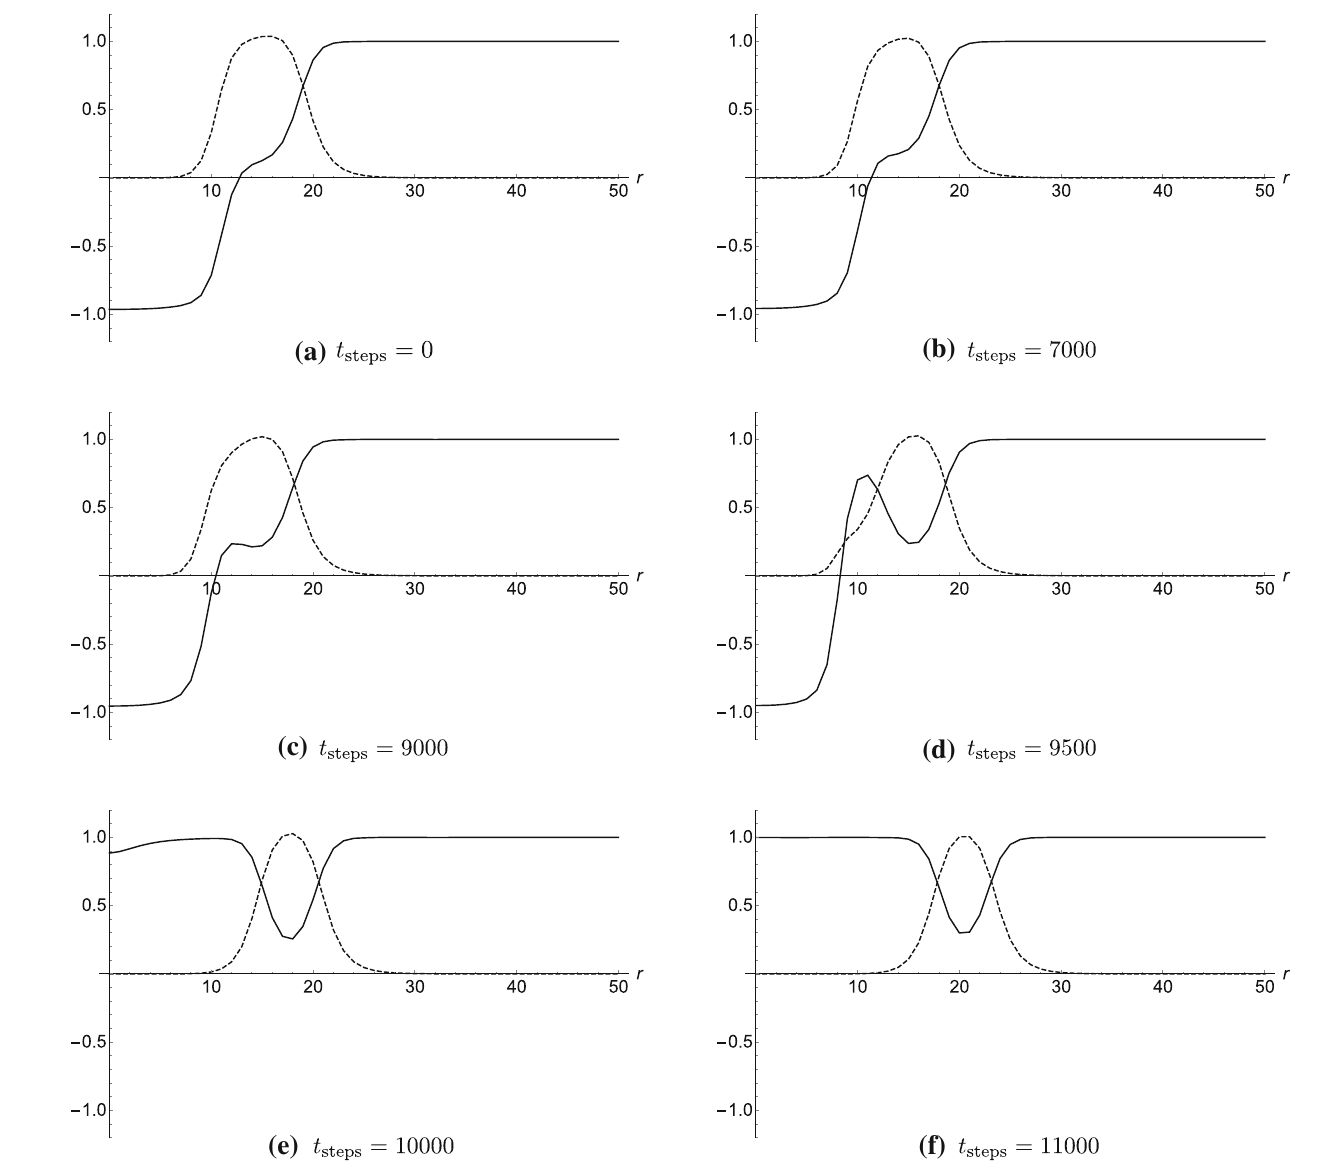
for decay. The parameters are λ φ = 4 . 5, λ σ = 4 . 0, η = 1, γ = 2 . 8, m = 10, and g = 0 .